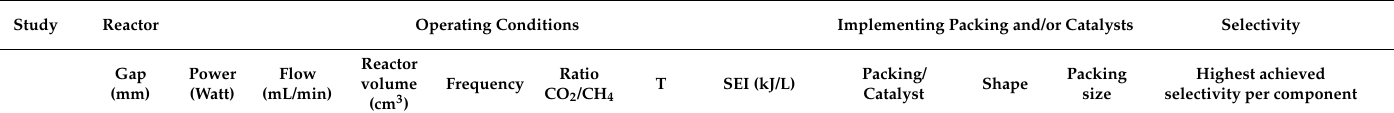
Table 1. Summary of a selection of literature for CO 2 splitting in a non-packed and a packed DBD reactor.